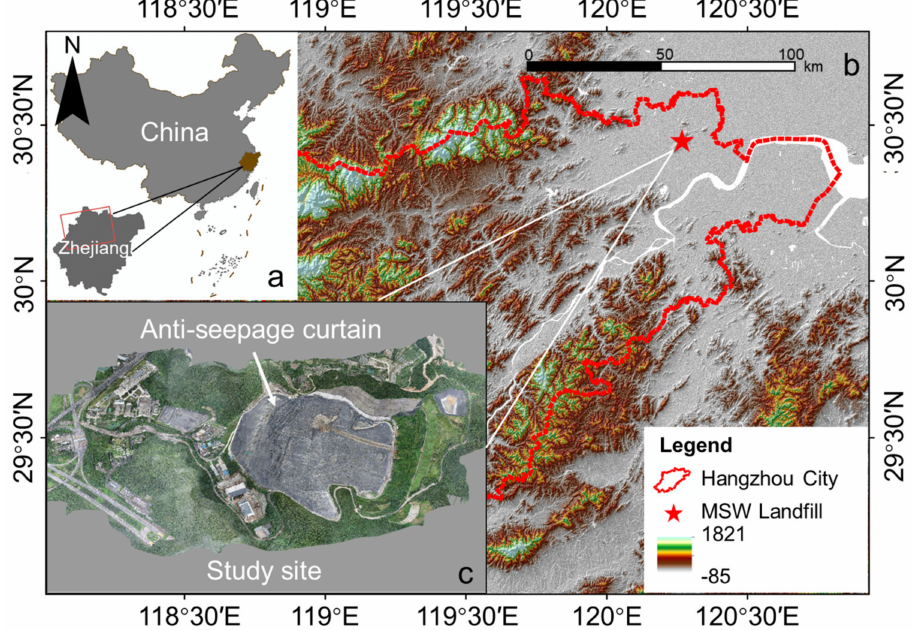
Figure 1. Location and topography of study site: ( a ) China and Zhejiang province, whereby the red box shows the coverage of the Sentinel-1 images; ( b ) DEM of Hangzhou City; ( c ) UAV 3D model of study site, whereby the white arrow indicates the vertical anti-seepage